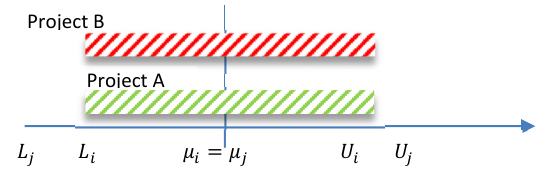
Fig. 8. Possible Condition 1- Similar Means and Similar Domain